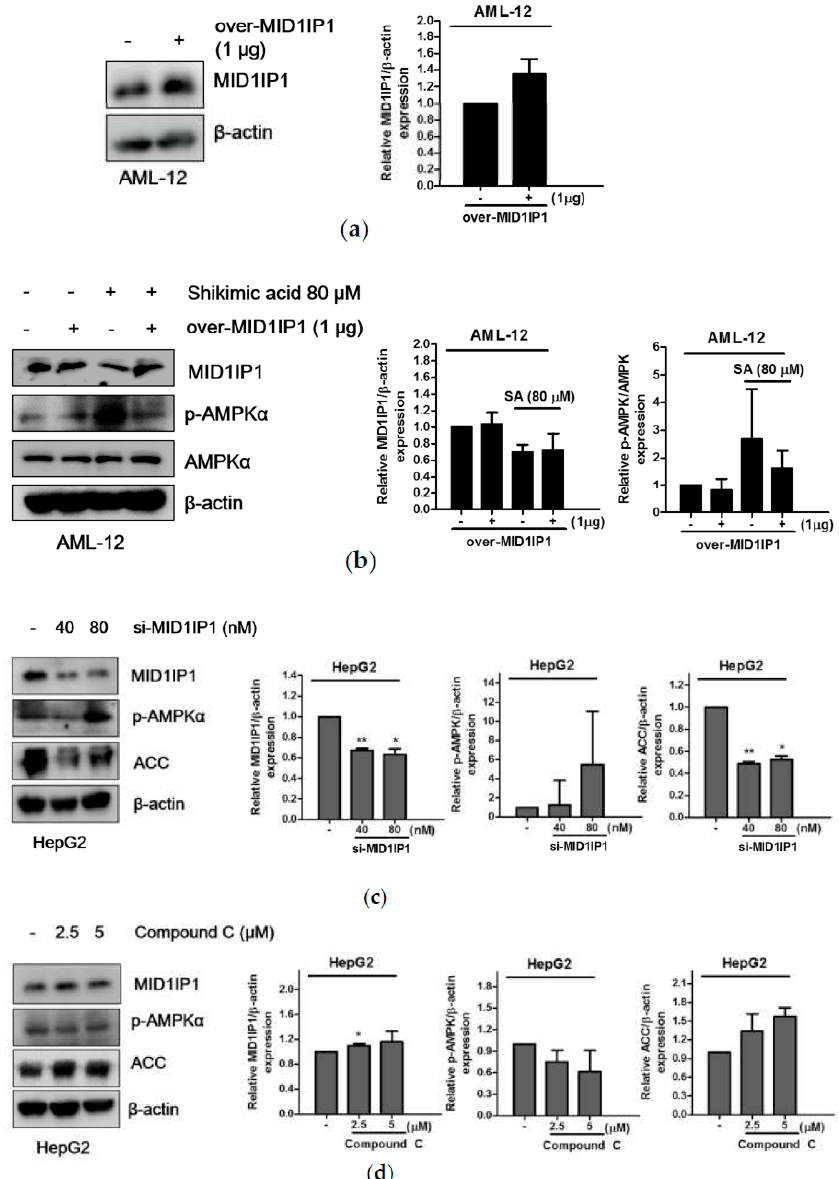
Figure 5. Close relationship between MID1IP1 and AMPK in HepG2 cells. ( a ) Overexpression level of MID1IP1 in AML-12 cells. ( b ) MID1IP1 overexpression for 48 h disturbed phosphorylation of AMPK in AML-12 cells. ( c ) Depletion of MID1IP1 (0, 40, 80 nM) activated phosphorylation of AMPK in HepG2 cells. ( d ) AMPK inhibitor compound c did not affect phosphorylation of AMPK in HepG2 cells. All experiments were independently performed at least three times. * p < 0.05, ** p < 0.01.